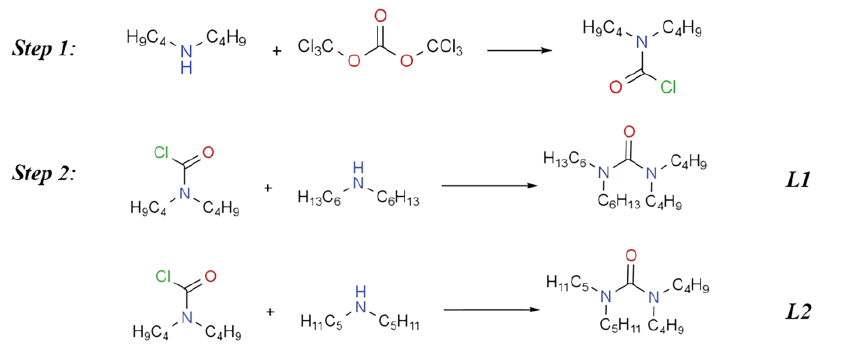
Figure 2. Reaction scheme for the synthesis of L .